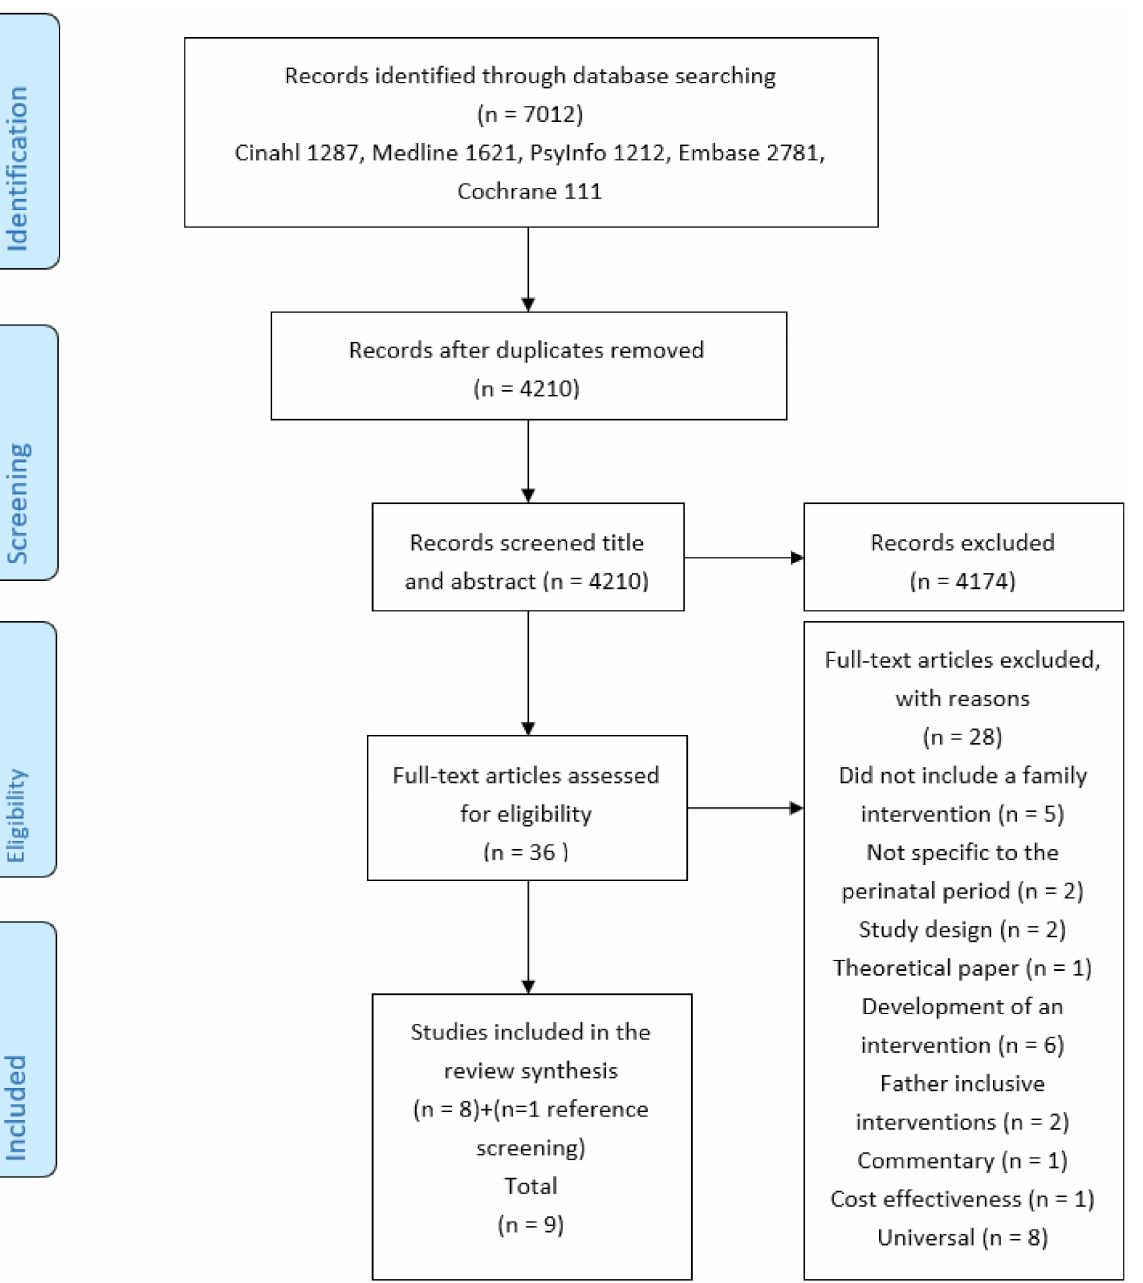
Figure 1. PRISMA 2009 Flow